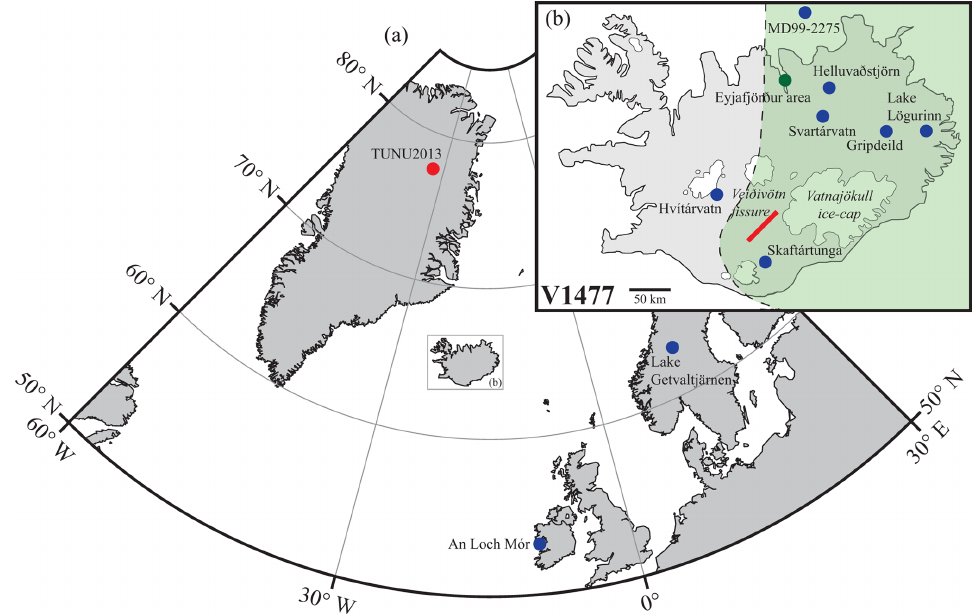
Figure 2. (a) Location map of the TUNU2013 ice-core drilling site and sites outside Iceland containing tephra attributed to the Veiðivötn 1477CE eruption. (b) Location map of Icelandic sites containing tephra from the Veiðivötn 1477CE eruption, from which geochemical characterisations were used in this study, the location of the historical report of the eruption and the 60–65km long fissure active during the 1477CE eruption. The green shaded area covers the 0.5cm isopach of the Veiðivötn 1477CE eruption. Adapted from Larsen et al.